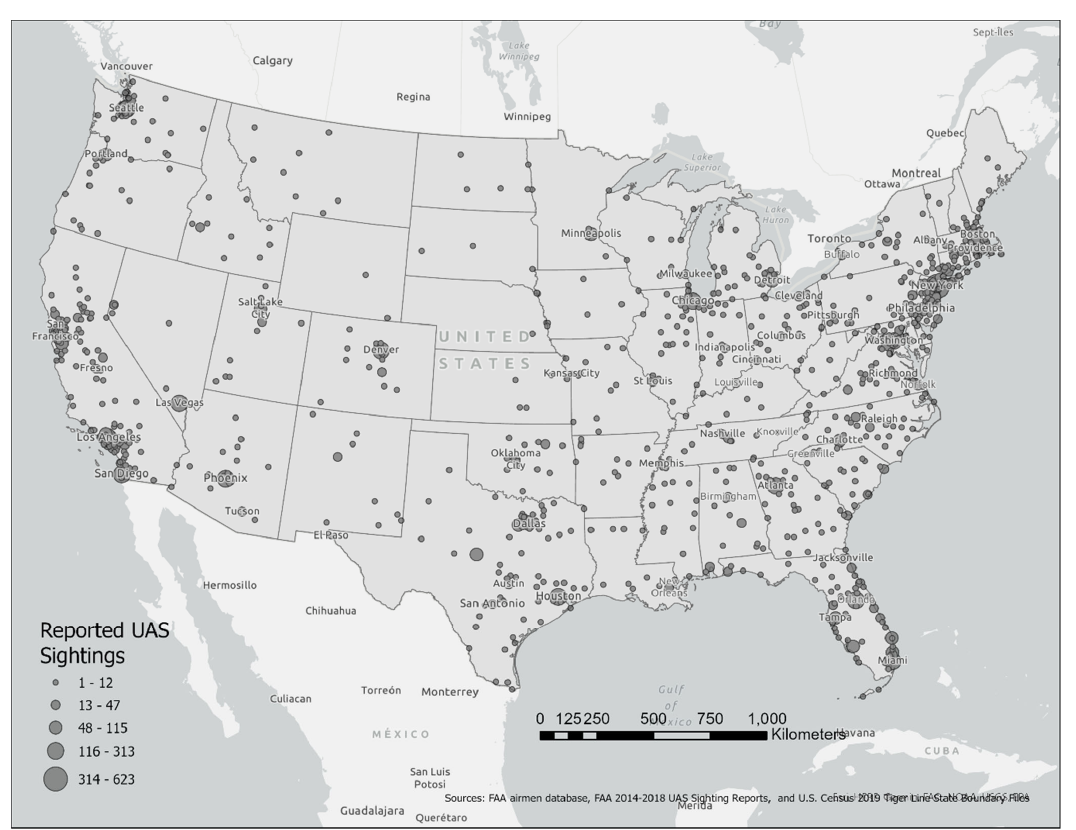
Figure 2. UAS sighting reports from 2014 to 2018 geocoded at the city level with frequency counts per city.